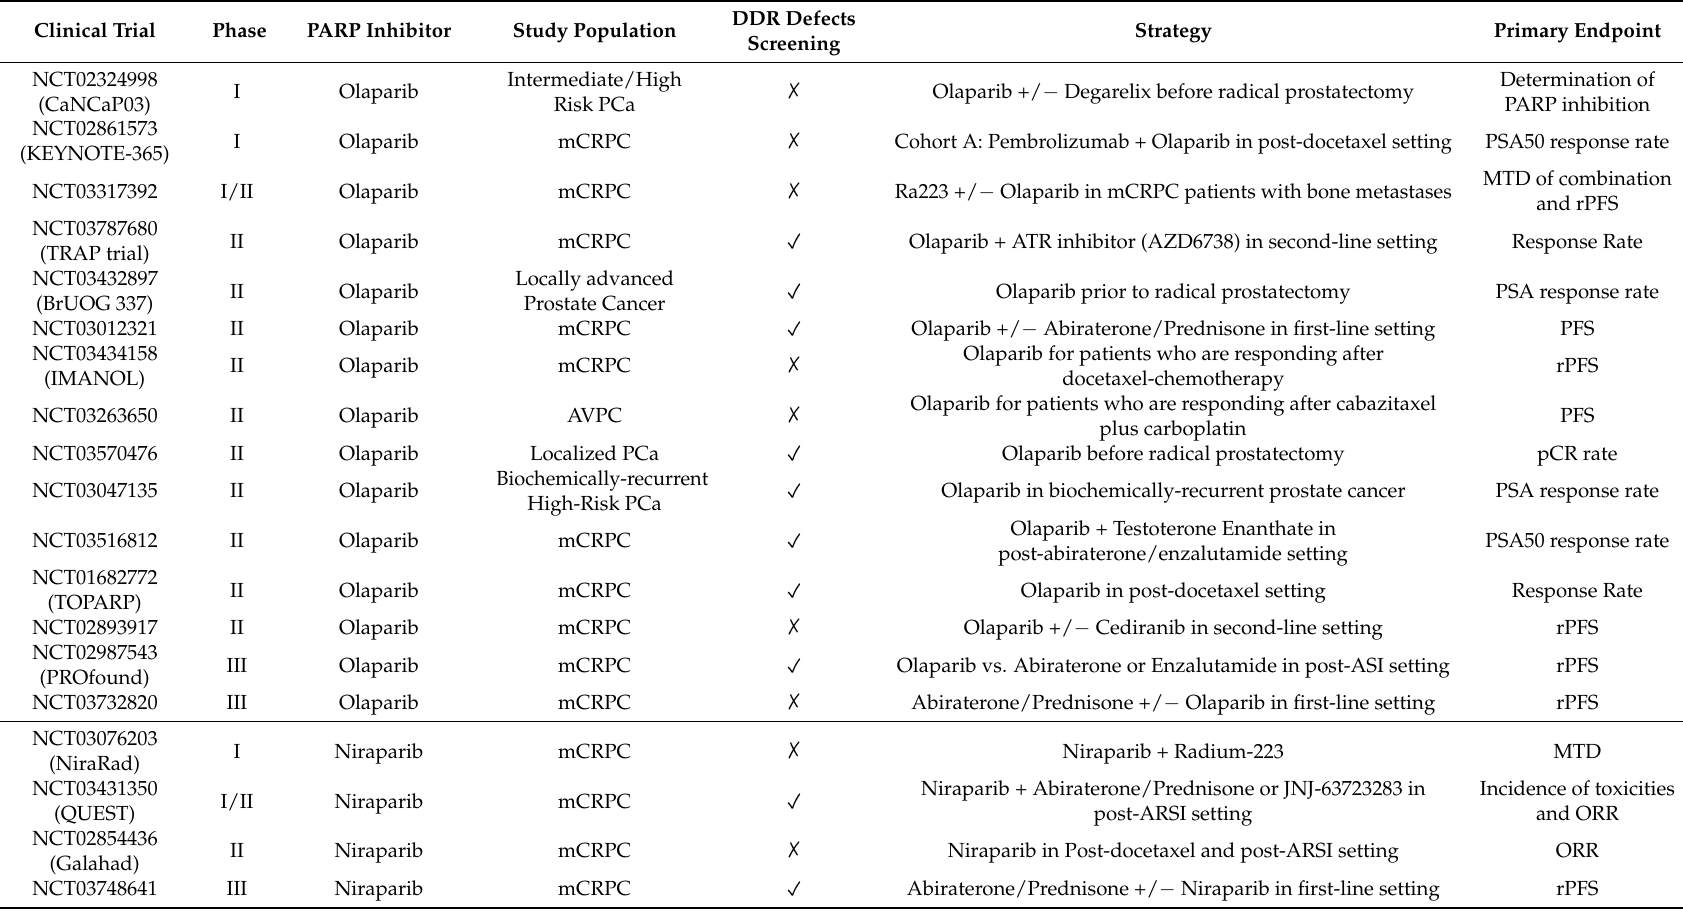
Table 2. Ongoing clinical trials evaluating PARP inhibitors in prostate